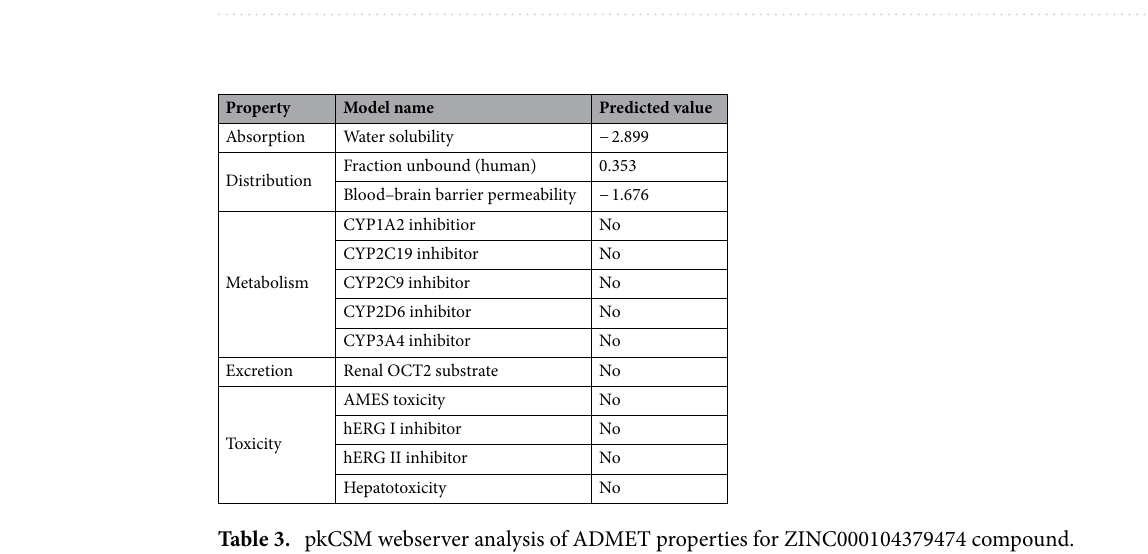
Table 2. Binding free energies and individual energy terms and their standard deviation of NSP15- ZINC000104379474 complex calculated by MM-GBSA. Units are in kcal/mole.